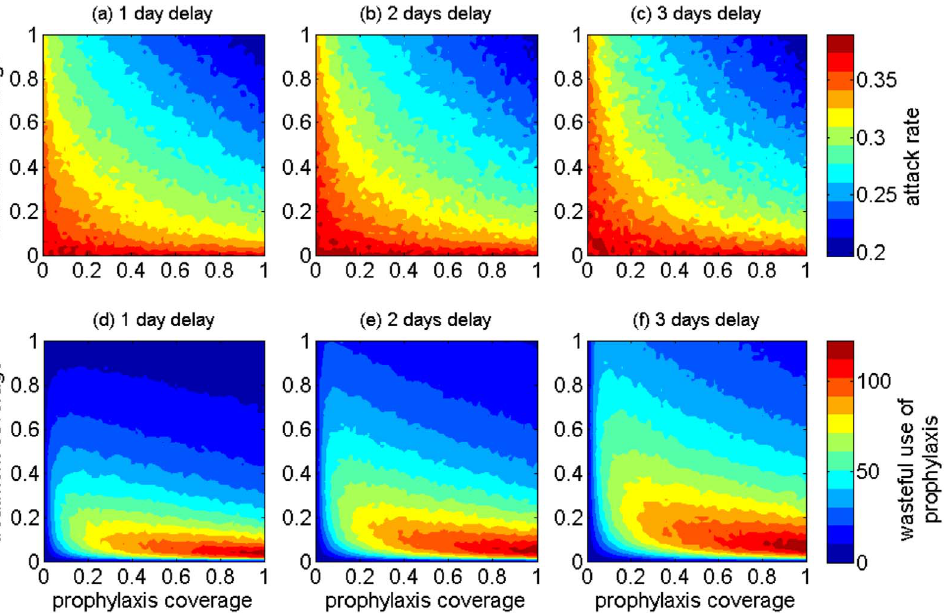
Figure 3. The projected effect of combining antiviral treatment of infectious cases with prophylaxis of close contacts on population attack rates (a–c) and wasteful use of drugs (d–f) in the RC demographics when antiviral treatment delays (for infectious cases) range from 1 day to 3 days post symptom onset.